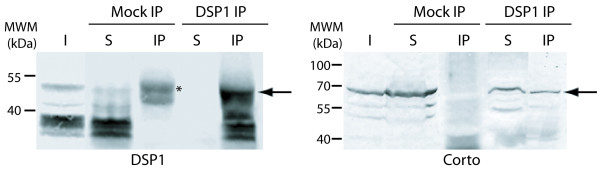
Corto and DSP1 interact in vivo. Co-immunoprecipitation of Corto with DSP1. Protein extracts from 0–14 hour-old w1118 embryos were incubated either with rabbit serum (mock IP) or with anti-DSP1 antibodies (DSP1 IP). Western blotting was performed using rabbit anti-DSP1 antibodies (left) or rat anti-Corto antibodies (right). The arrows indicate the full-length DSP1 protein (50 kDa) and Corto (68 kDa), respectively. I : Input ; S : supernatant; IP : immunoprecipitated material; *: rabbit IgG. Note that full-length DSP1 and degradation products were retained on the protein A-agarose/anti-DSP1 beads.